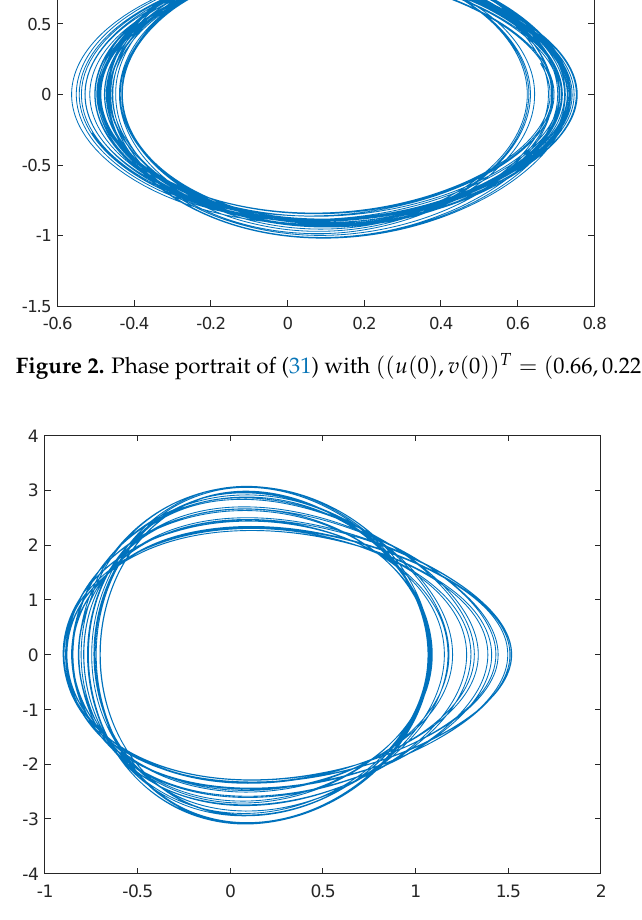
Figure 3. Phase portrait of (32) with (( u ( 0 ) , v ( 0 )) T = ( 1,1.1667 ) T